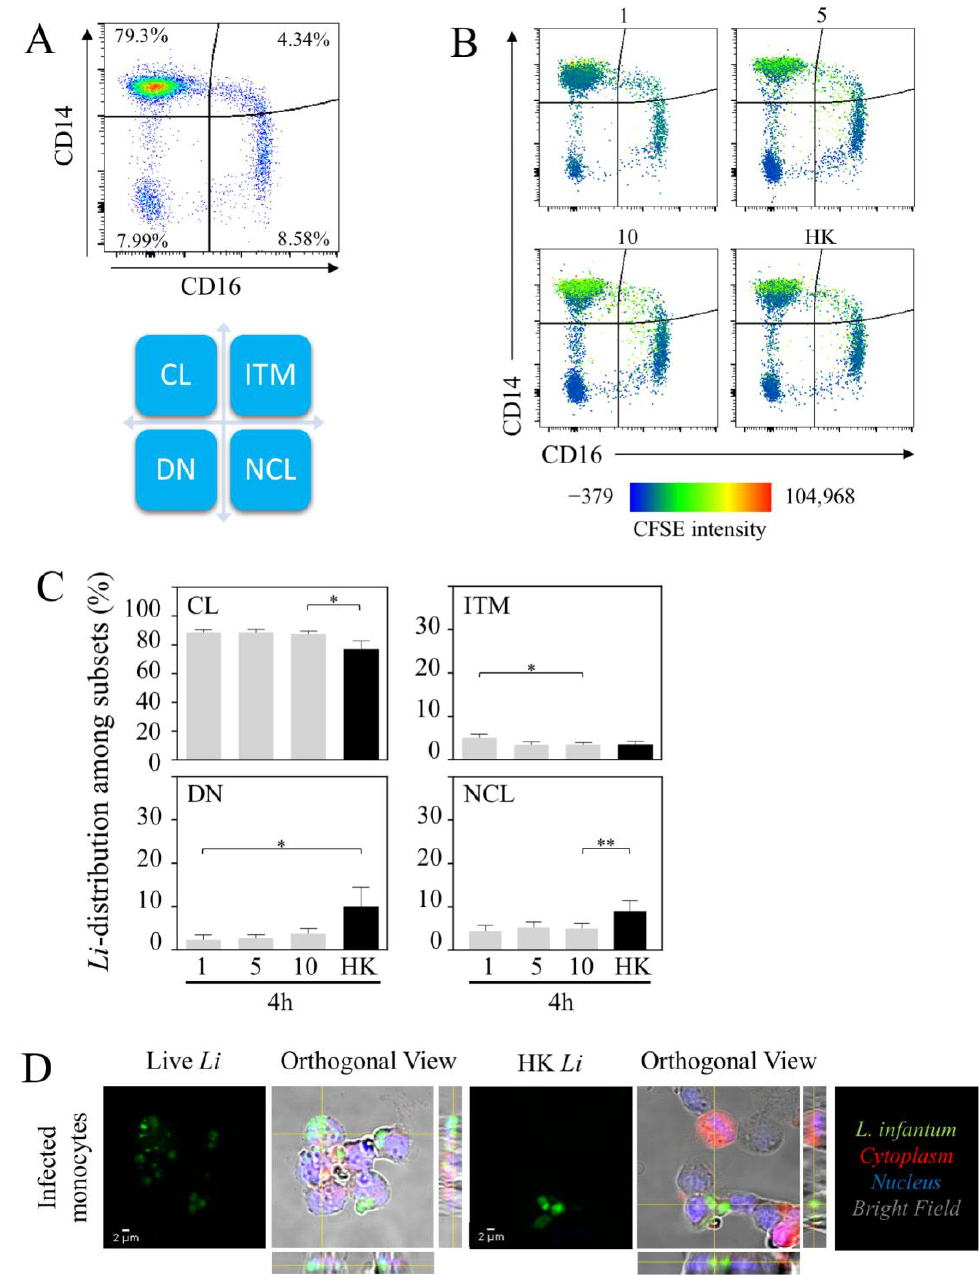
Figure 2. Leishmania infantum identifies CL as a main reservoir. ( A ) Dot plot showing the expression of CD14 and CD16 on HLA-DR+ monocytes identifying the classical (CL), the intermediate (ITM), the non-classical (NCL) and the double-negative (DN) populations. ( B ) Representative heat-map view of CFSE-labeled parasites. Color intensity of parasite is shown in each population of monocytes. ( C ) Parasite distribution in each monocyte subset 4 h after infection with 1.10 6 , 5.10 6 or 10.10 6 of live parasites is noted as 1, 5 and 10, respectively, and heat-killed (HK, 10.10 6 ). ( D ) Confocal microscopy of monocytes infected with live or HK L. infantum ( Li ) in CFSE (green). Bright field associated with CellTracker allowed to determine the membrane and the cytoplasm (red) of each cell. Standard deviation intensity projection of x, y and z axes confirmed that the parasites were localized inside the cells (orthogonal view). Statistical analysis was performed using one-tailed Wilcoxon test (* p < 0.05, ** p < 0.01; n = 7).